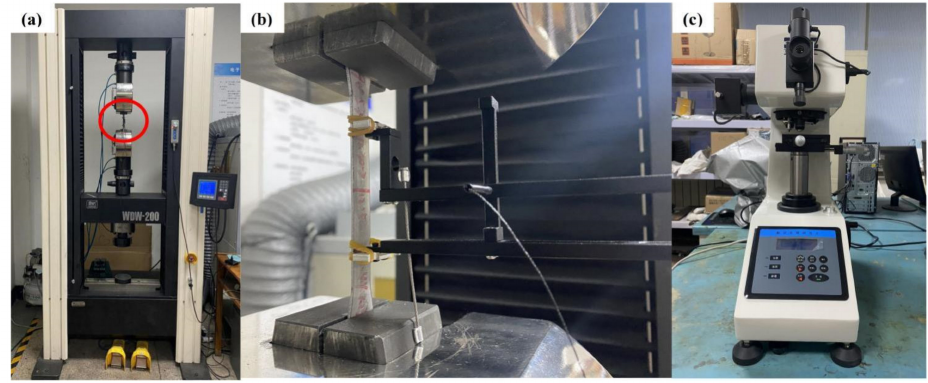
Figure 3. WDW-200 electronic universal testing machine ( a ); extensometer ( b ); and micro-Vickers hardness tester ( c ).